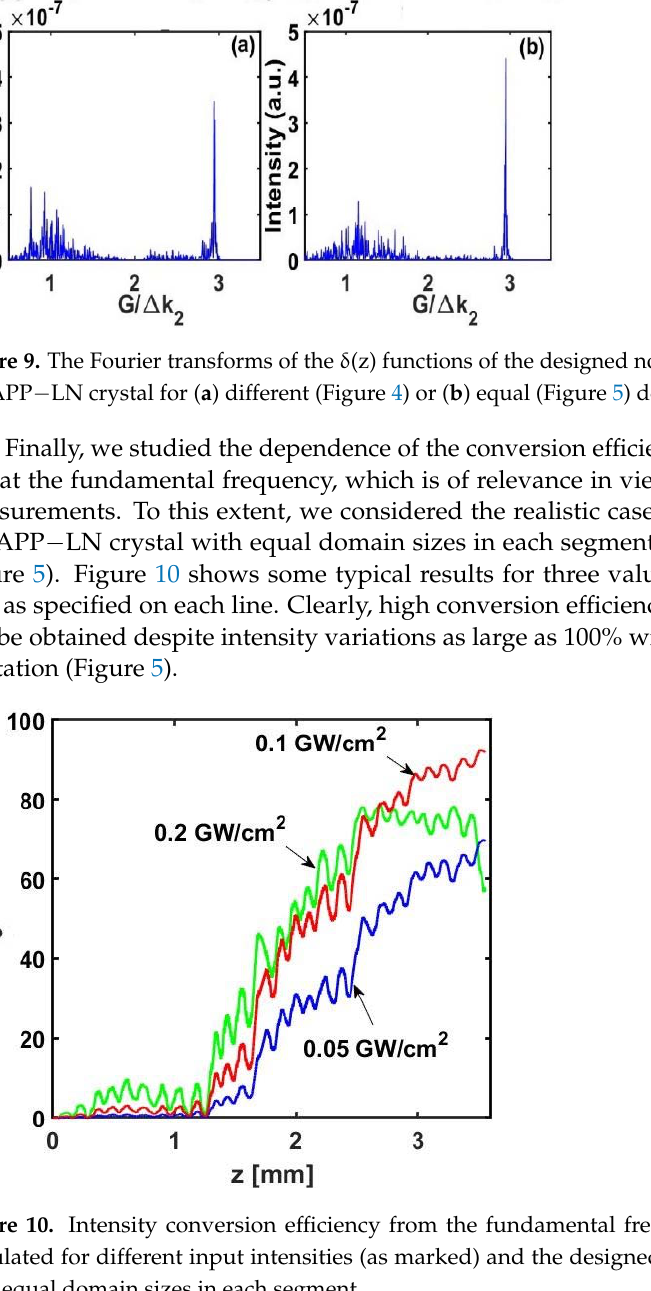
Figure 8. The Fourier transforms of the δ ( z) functions of the designed nonlinear lattices. ( a , b ) refer to the dimensionless case for ( a ) different (Figure 2) or ( b ) equal (Figure 3) domain sizes in each segment.